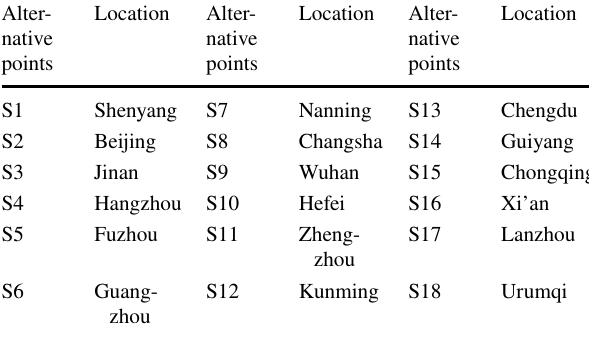
Fig. 3 Layout of the original rescue rig reserve points ( a ); and lay- out of alternative configuration points ( b ). See Tables 4 and 5 for site names. Table 5 Alternative configuration points of rigs